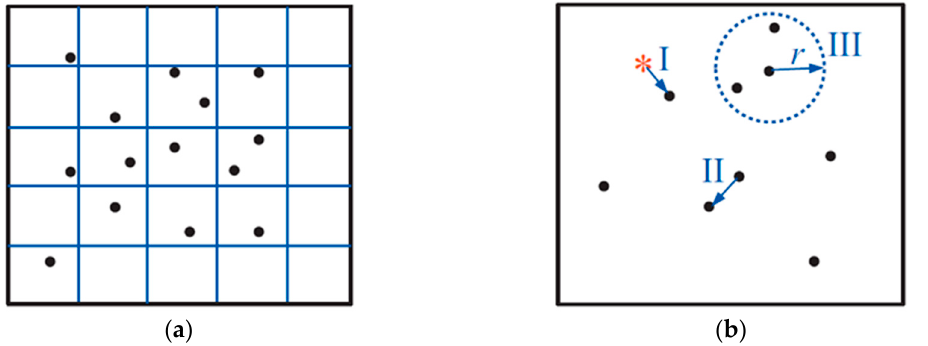
Figure 2. Illustration of ( a ) quadrat-based methods and ( b ) distance-based methods. Reproduced from [17], with permission from Elsevier, 2013.